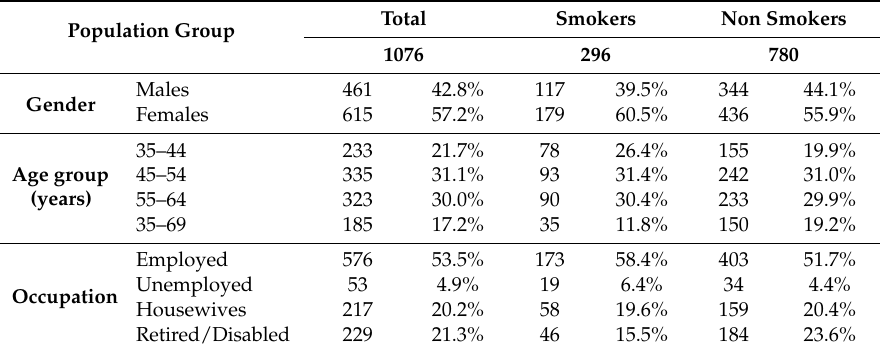
Table 1. Characteristics of the study population by smoking